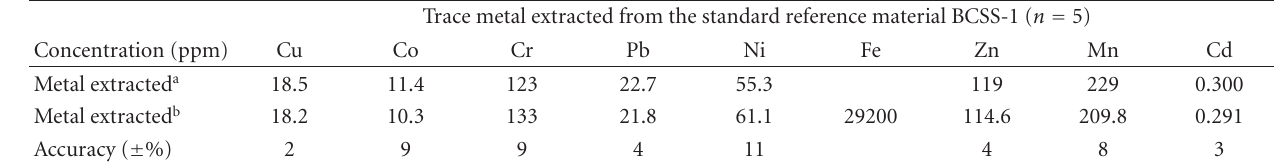
Table 1: Trace metal extracted from the standard reference material BCSS-1. Trace metal extracted from the standard reference material BCSS-1 ( n =